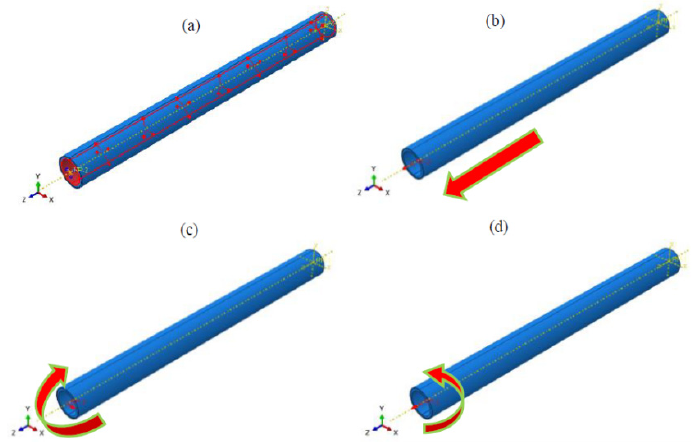
Figure 5. Schematicdiagram of the loading of the RTP: ( a ) inner pressure; ( b ) tension; ( c ) bending; ( d ) torsion.